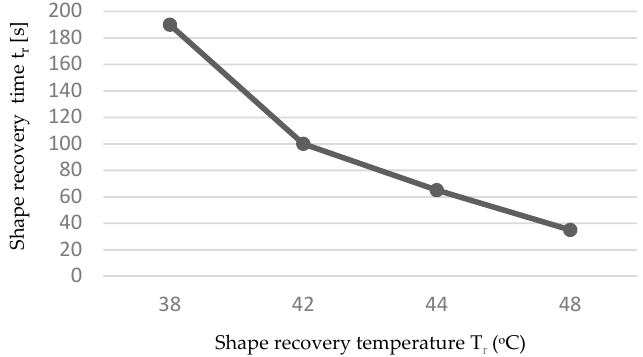
Figure 5. Dependence on the shape recovery time versus shape recovery temperature in the shape memory spiral shaped nonwoven fabric experiment.